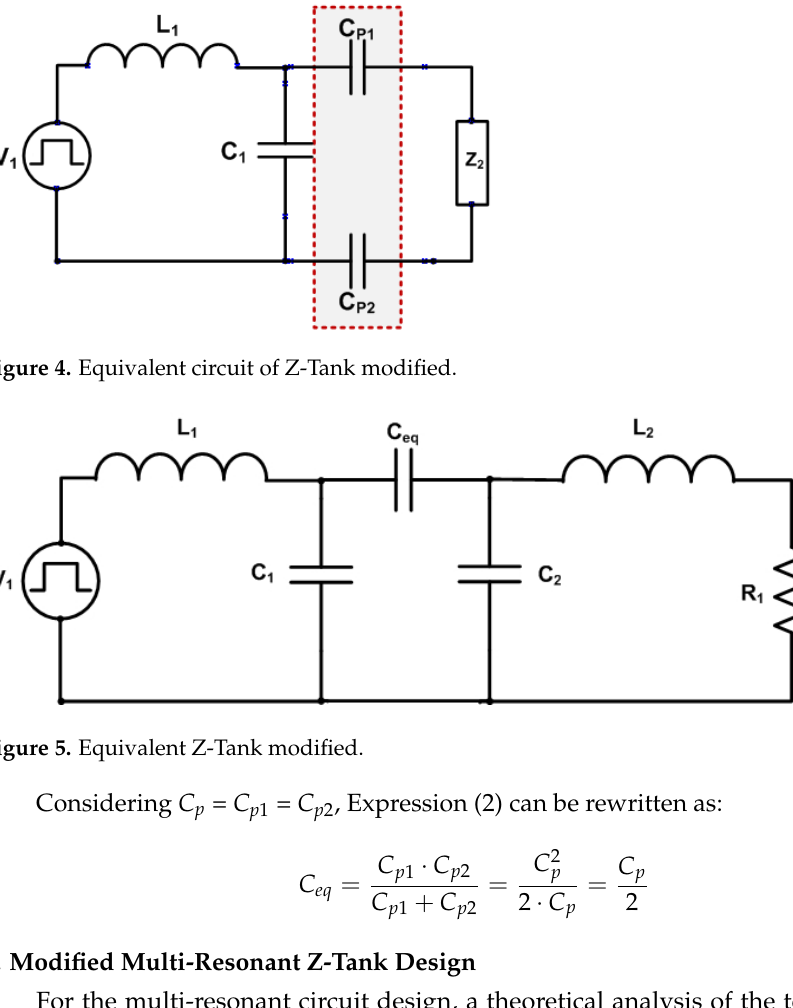
Figure 5. Equivalent Z-Tank modified.